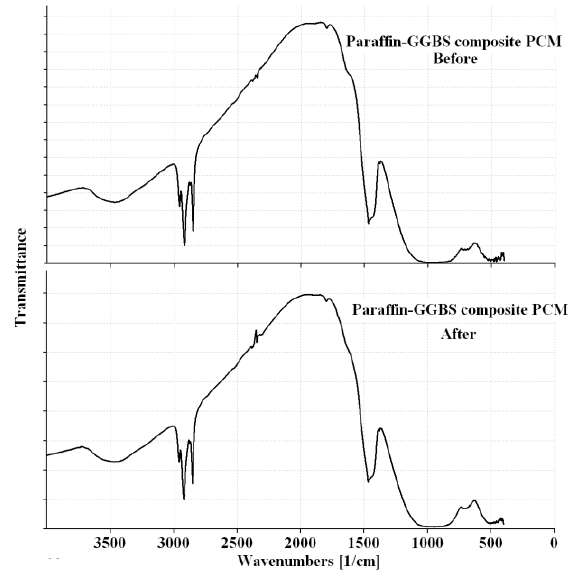
Figure 9. FT-IR spectra of Paraffin-GGBS composite PCM before and after thermal